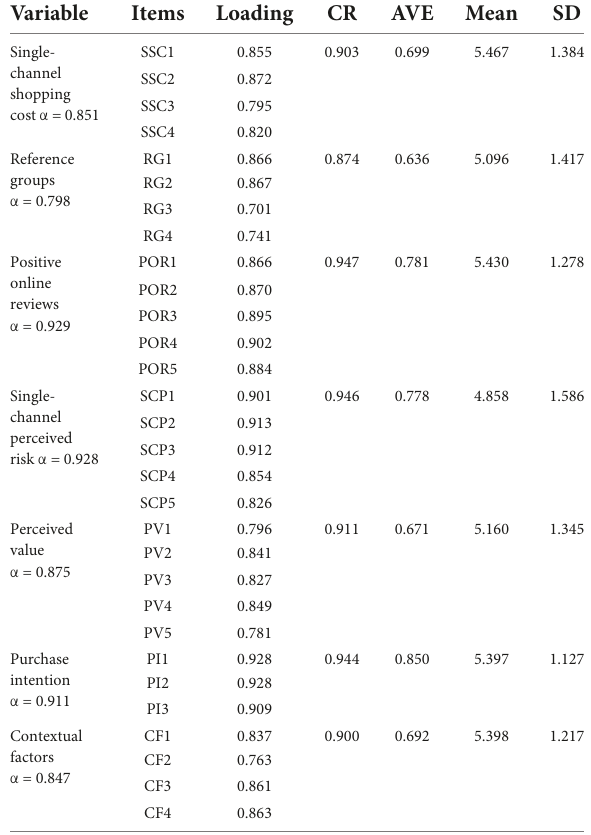
TABLE 2 Construct reliability and convergent